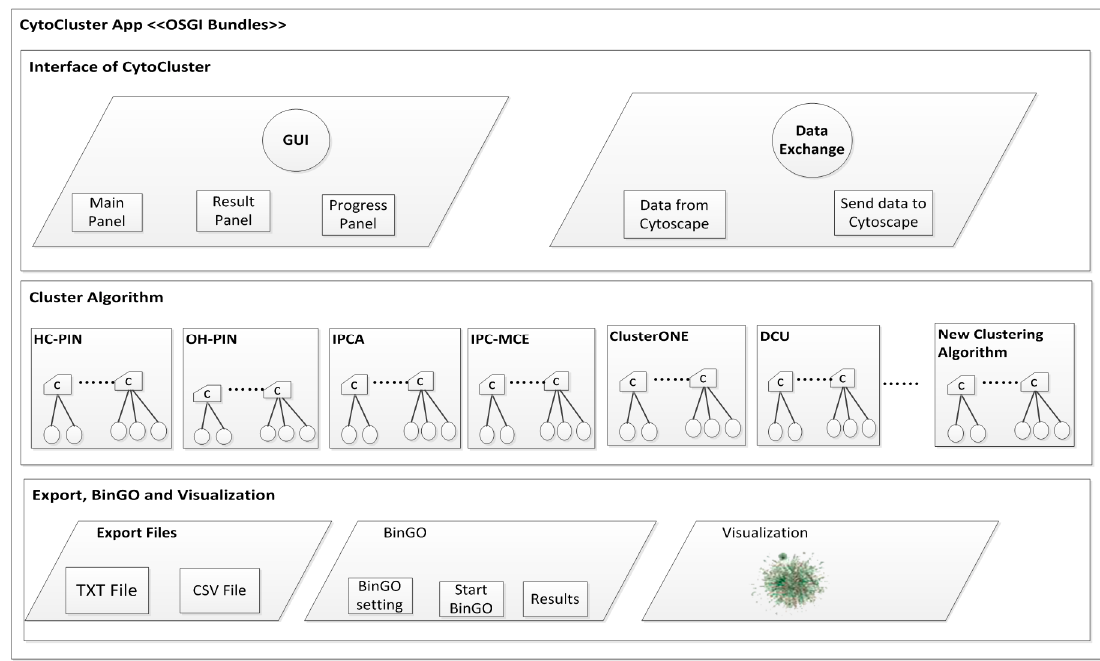
Figure 1. Architecture of CytoCluster.